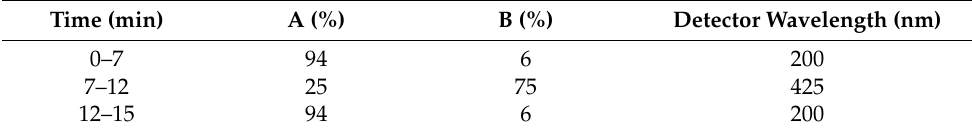
Table 1. Gradient conditions for simultaneous analysis of CUR and